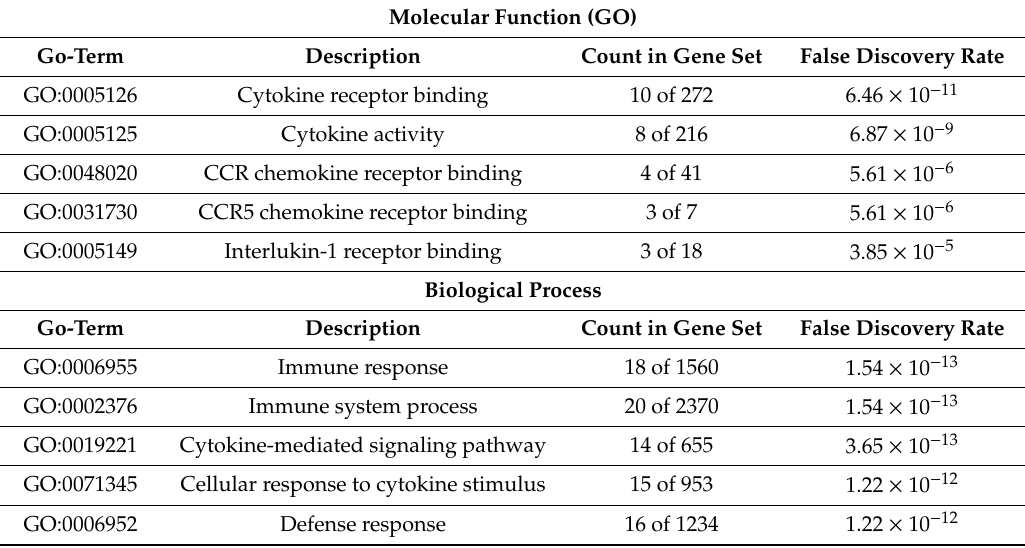
Table 3. Functional annotations of the di ff erentially expressed